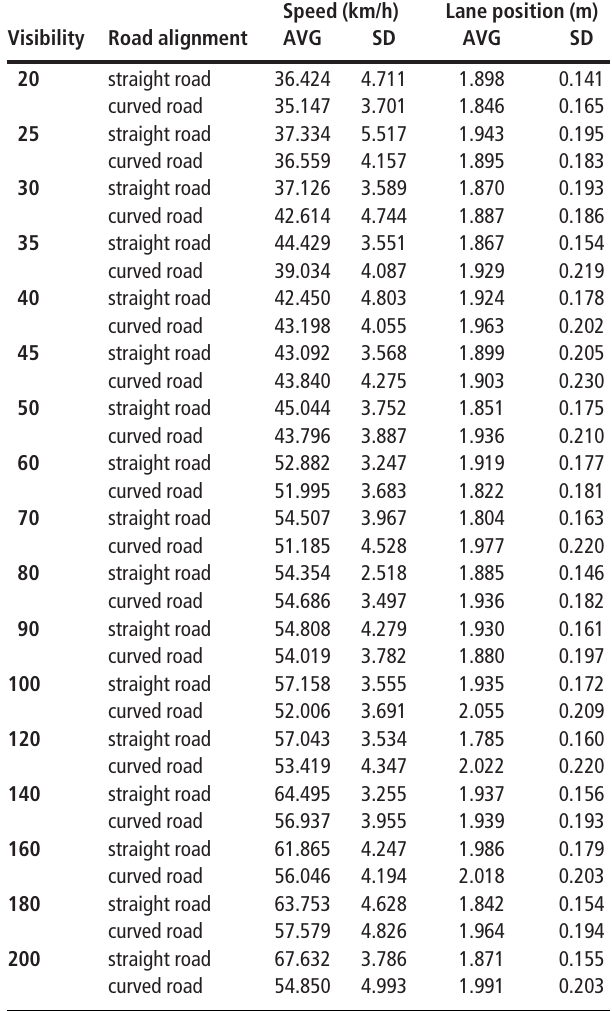
Table III Vehicle speed and lane position for each